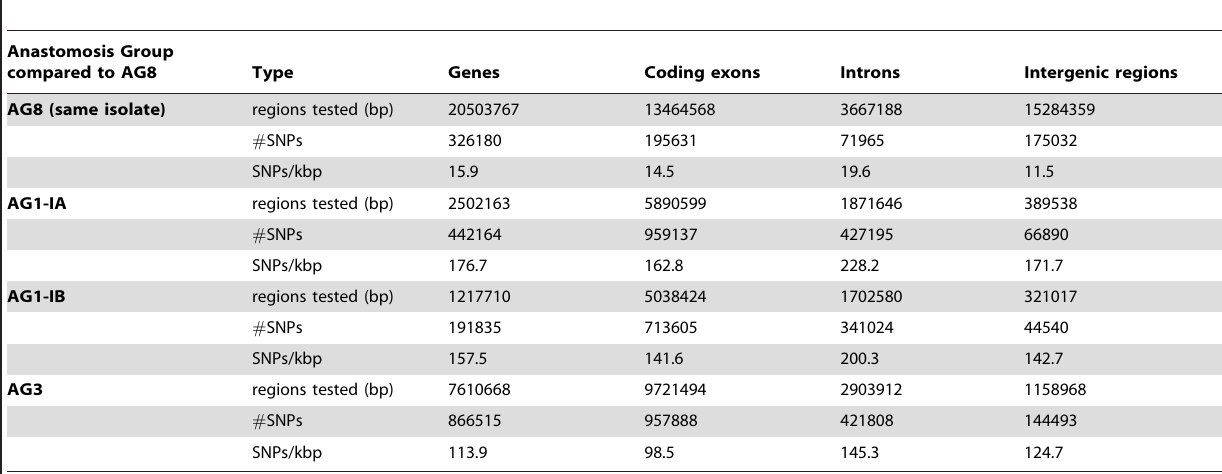
Table 3. The frequency and relative densities of heterozygous SNPs within the R. solani AG8 genome assembly and SNPs between the genomes of AG8 and isolates from other anastomosis